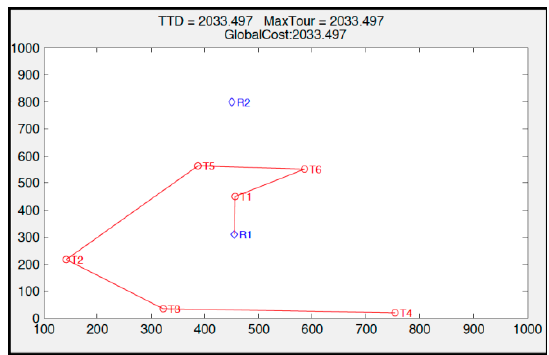
Figure 7. Market-based approach using fire scenario with two robots and six tasks.